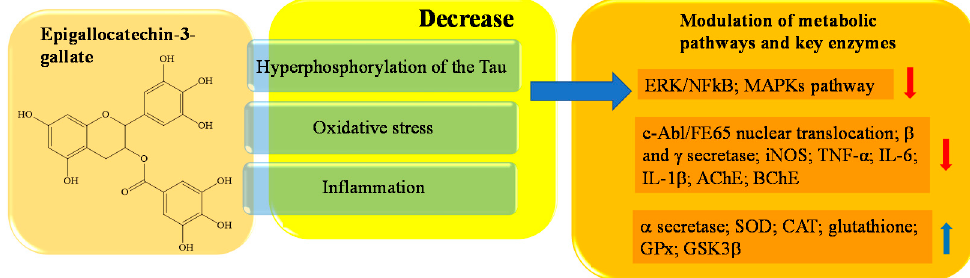
Figure 6. Schematic effects of epigallocatechin-3-gallate on molecular targets of AD.